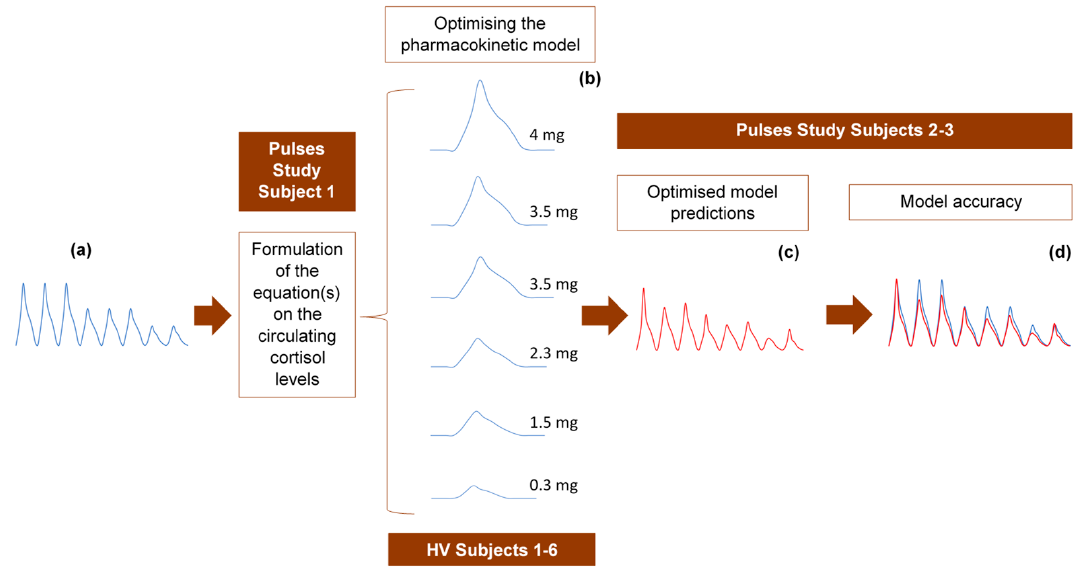
Figure 6. Strategy for developing and optimising the pharmacokinetic model, describing the subcutaneous delivery of hydrocortisone (HC). ( a ) One of the 24-h cortisol profiles (blue diagram) was selected at random and used to formulate an equation describing plasma cortisol dynamics. We assumed constant rates of HC absorption and clearance and showed that such an approach cannot simulate reality. Three different scenarios were subsequently tested, of which only one was finally selected. ( b ) The selected optimised scenario assumes varying rates of HC absorption and clearance depending on the dose magnitude and circulating cortisol levels, respectively. The six 3-h healthy volunteer profiles (blue diagrams) under different subcutaneous doses of HC were used to validate these assumptions and confirm the reliability of the model. ( c ) Four plasma cortisol values from each of the remaining two patients with adrenocortical insufficiency were inputted into the model to predict their whole 24-h hormonal profile (red diagram). ( d ) The (theoretical) output of the model (red diagram) was compared to the actual 24-h plasma cortisol profile (blue diagram) of each of the two patients. HV: healthy